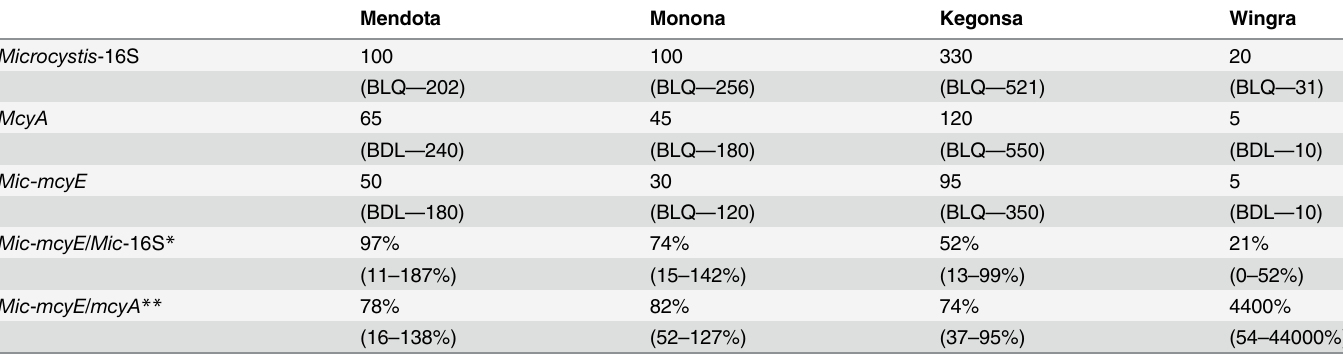
Table 3. Summary qPCR statistics for each of the four